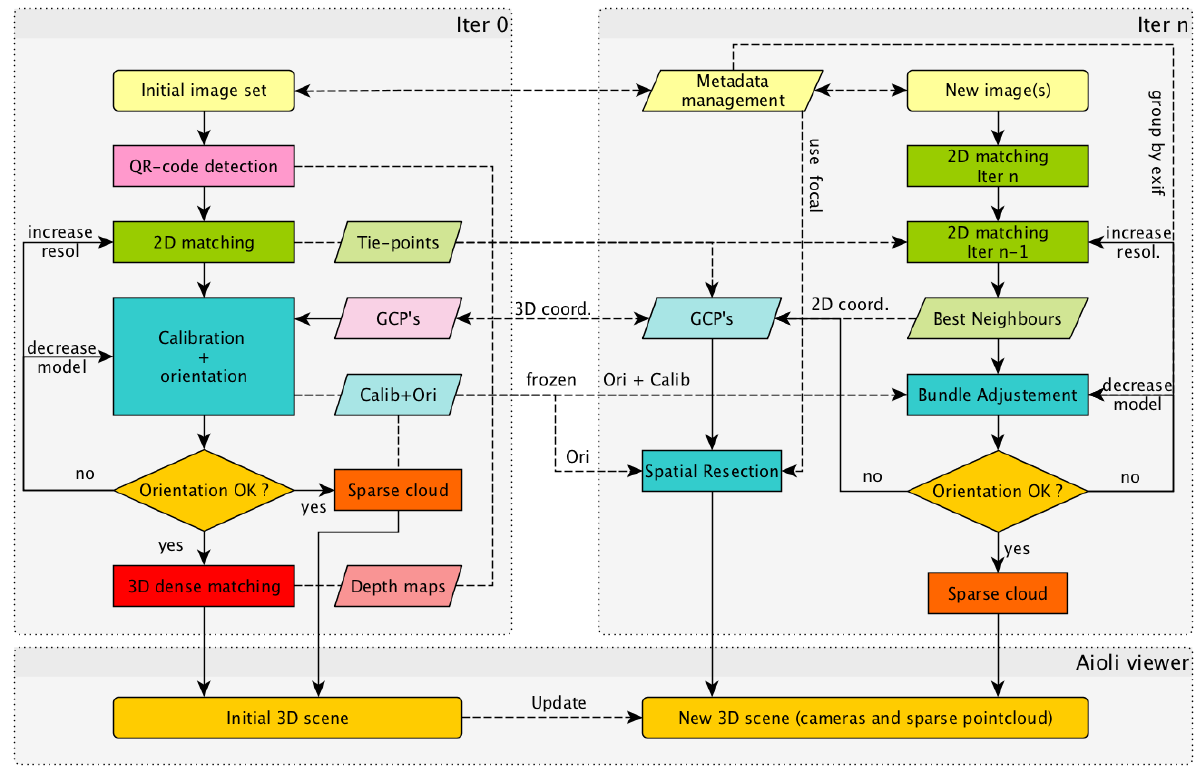
Figure 3: Diagram of the iterative co-registration processing for SO-RTI